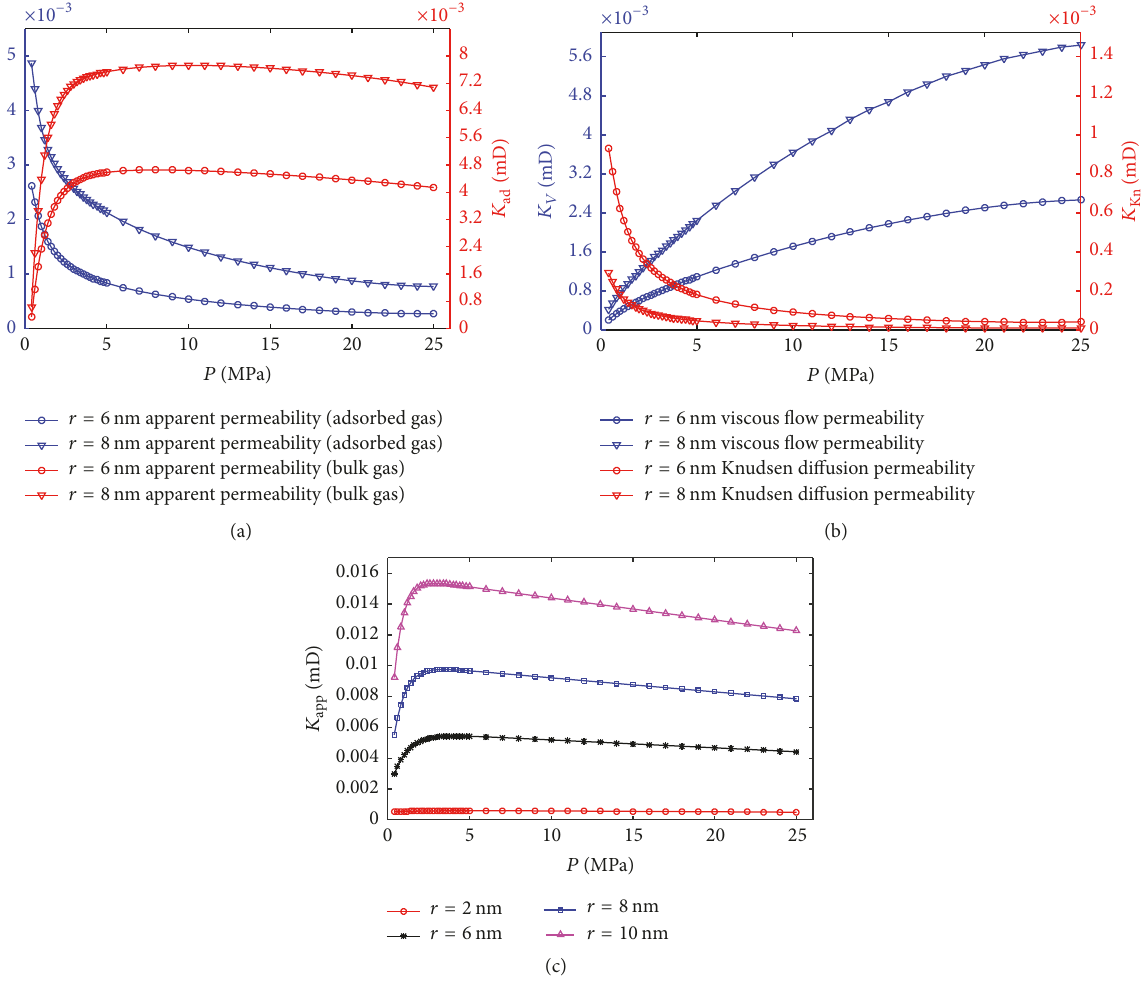
Figure 2: Variation of 𝐾 app , ad , 𝐾 V , 𝐾 app , Kn , and 𝐾 app ,𝑡 with average